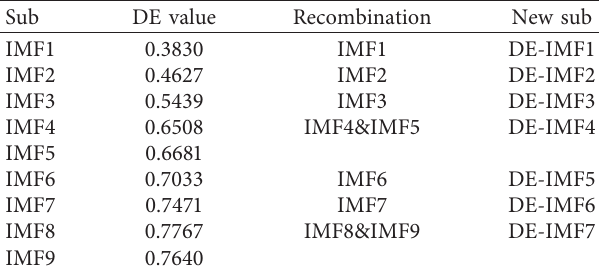
Table 2: Recombined by the DE value of VMD subsequence of data set B.